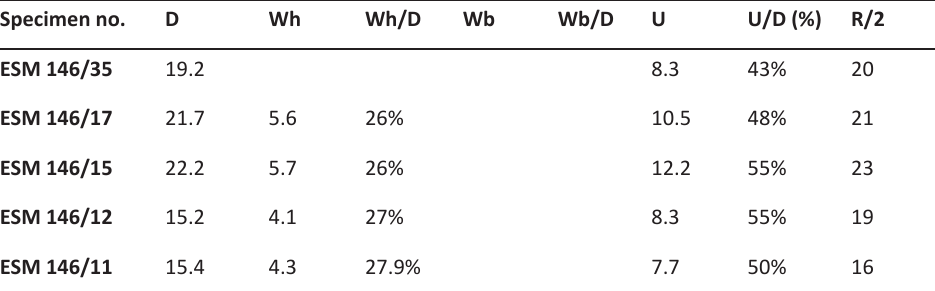
Table 2. Measurements of Dactylioceras (Microdactylites) sp.. D – diameter, Wh – whorl height, Wb – whorl breadth, U – umbilical diameter, R/2 – number of primary ribs per half of